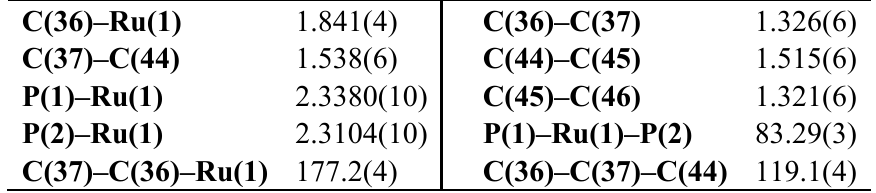
Table 1. Selected bond lengths [Å] and angles [deg] for complex 2a .